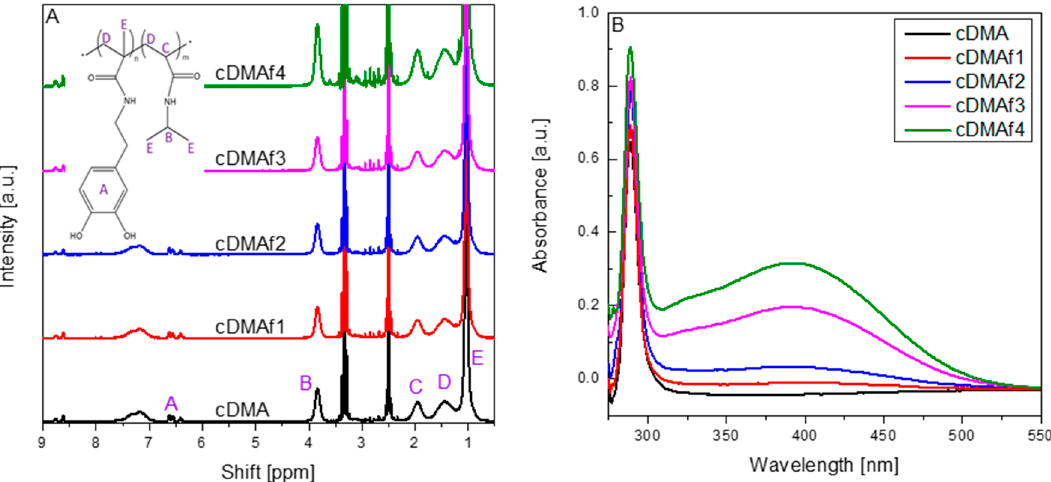
Figure 2. Molecular characterization for all the samples carried out by nuclear magnetic resonance ( 1 H NMR) in DMSO-d6 ( A ), and ultraviolet–visible (UV–vis) spectroscopy ( B ).